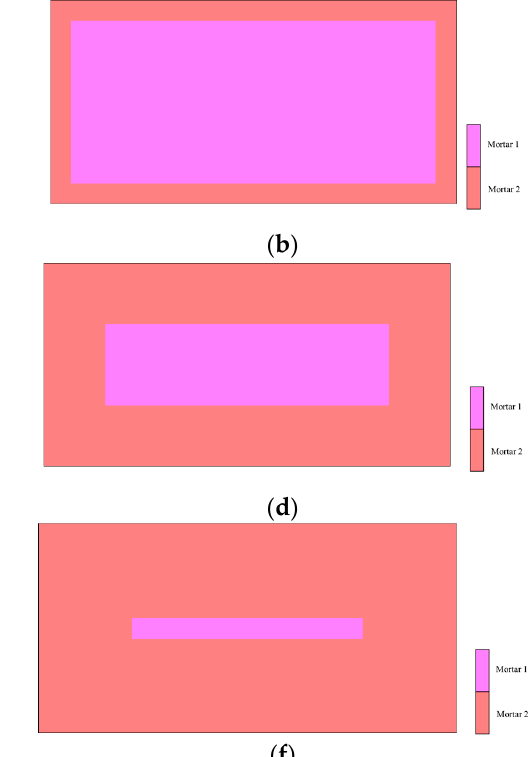
Figure 10. Analysis results of the waveforms.